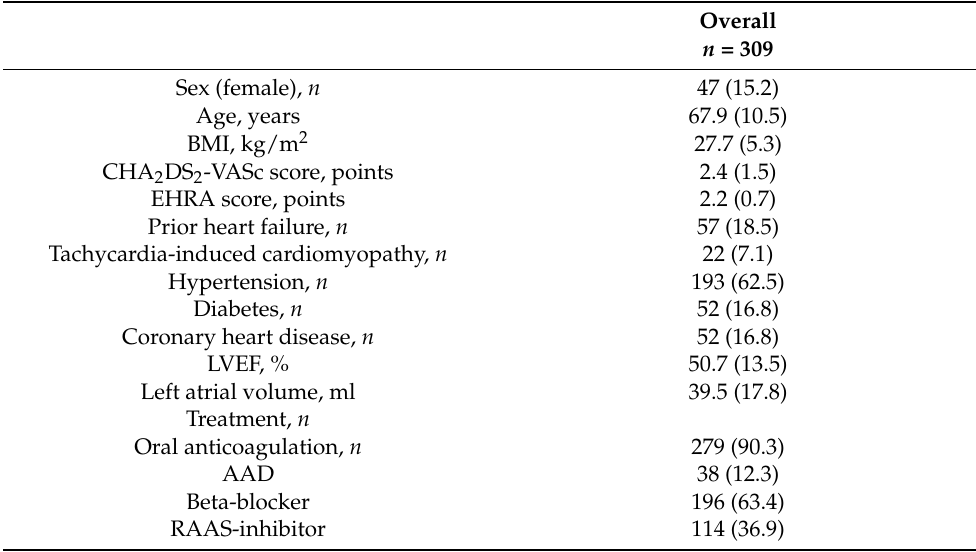
Table 1. Baseline